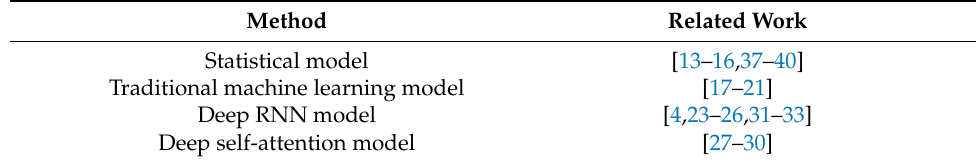
Table 1. A brief summary of related